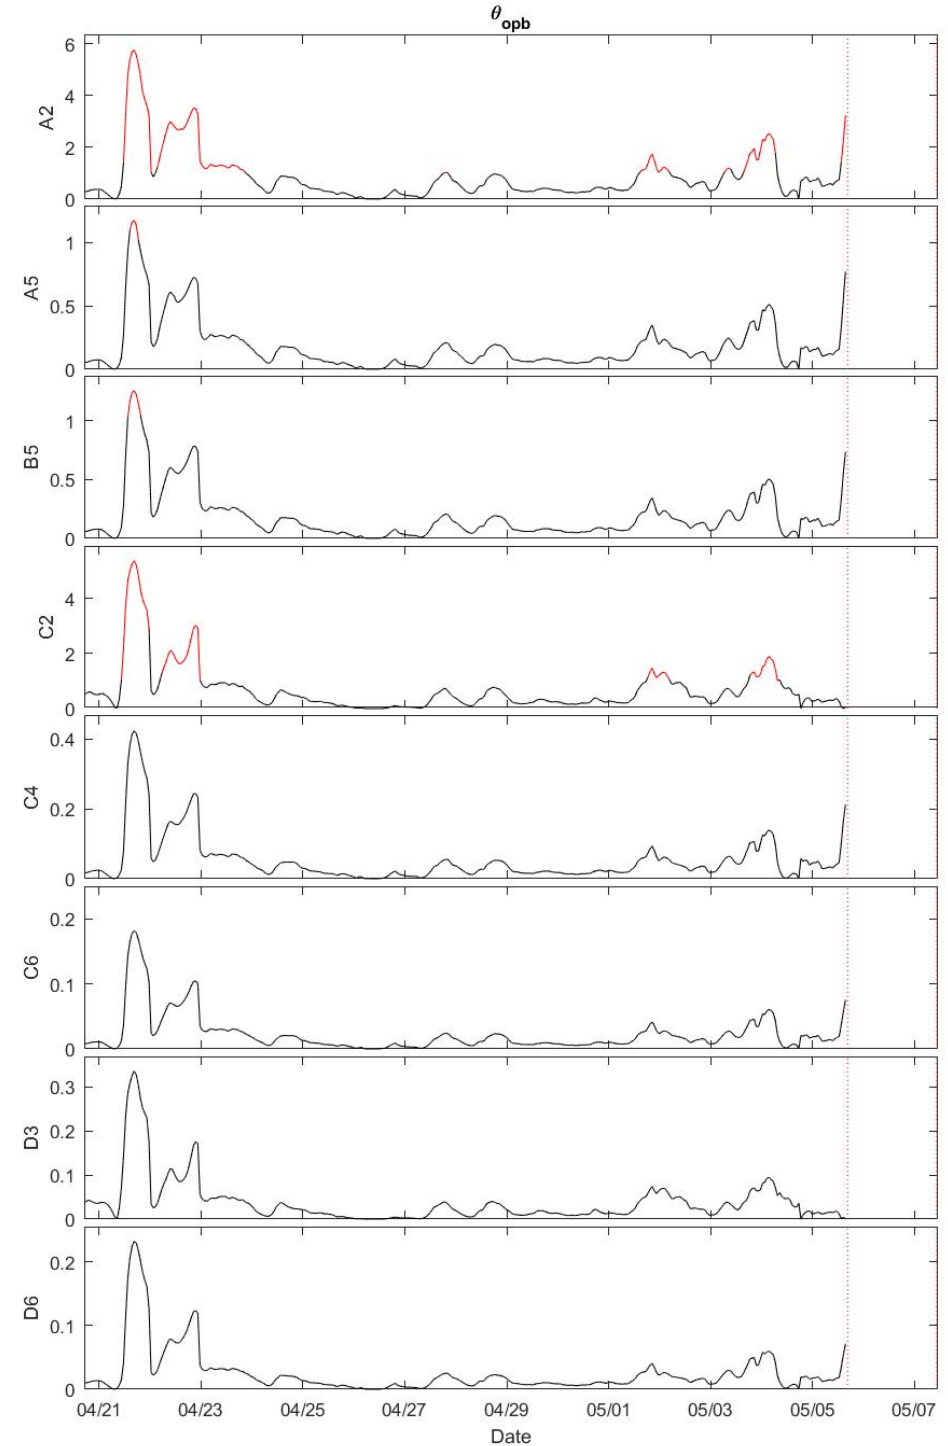
Figure 11. Model predicted objects’ mobility parameters for percentage burial ( θ opb ) at the shallow quadpod from 20 April to 7 May 2013. The red color shows that the condition for rolling an object [ θ opb > 1] is satisfied. The parameters θ opb is not computed between 12:00 5 May to 00:00 6 May 2013, since the predicted burial percentage p B ( t ) is larger than 0.5. Among the eight objects, only A2 and C2 have evident time periods when the condition for rolling an object [ θ opb > 1] is satisfied.